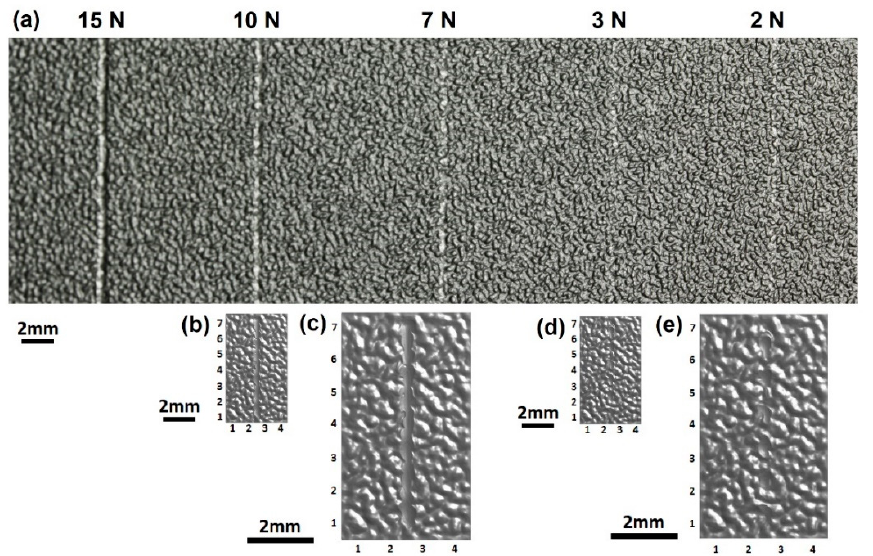
Figure 8. Images of scratches ( a ) produced by instrument under different forces and simulated under ( b , c ) 10 N and ( d , e ) 3 N on the SB texture. Images ( c ) and ( e ) are enlarged views of the simu- lated scratches presented in ( b ) and ( d ).